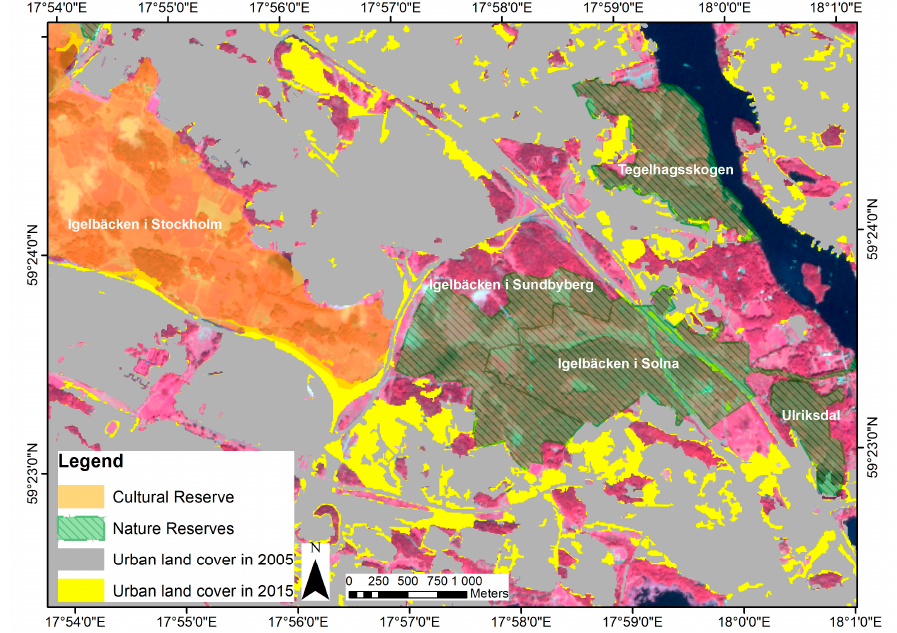
Figure 9. Urban expansion around Igelbäcken cultural and nature reserves in Stockholm, Sundbyberg and Solna Municipalities between 2005 and 2015.